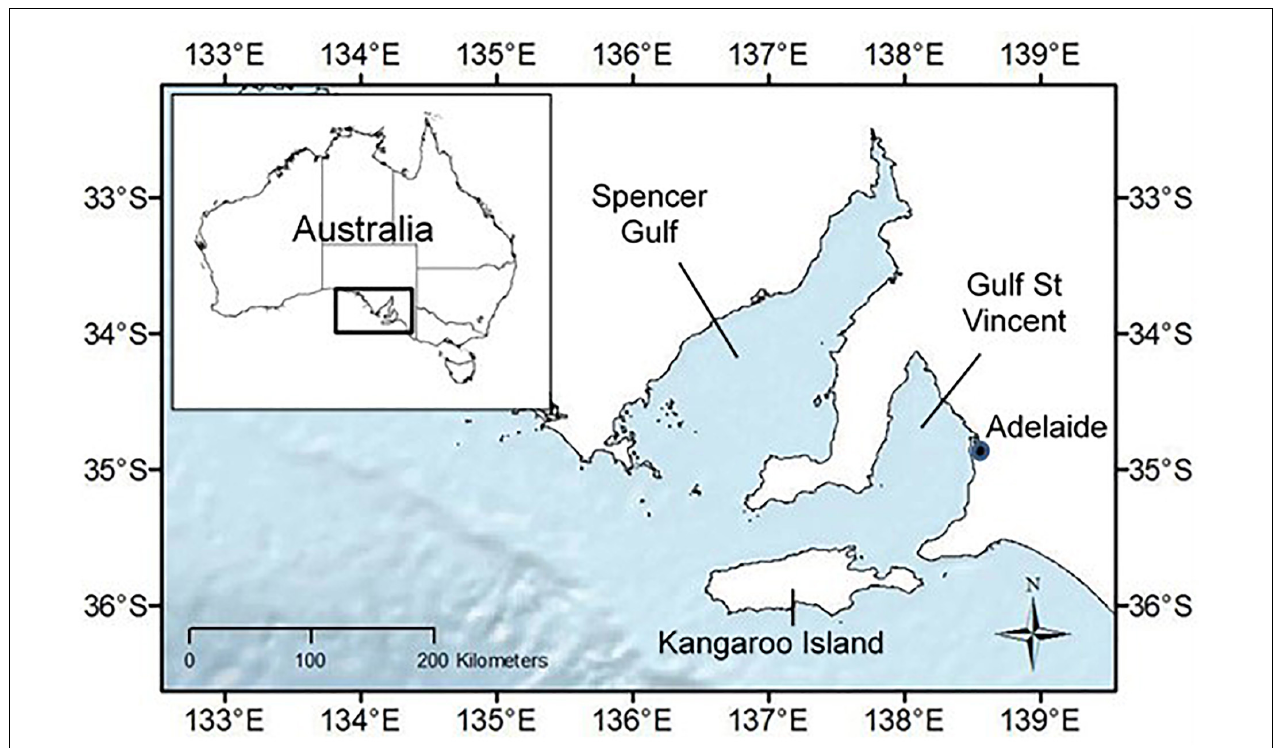
FIGURE 1 | Map of the study regions of Spencer Gulf and Gulf St Vincent located in southern